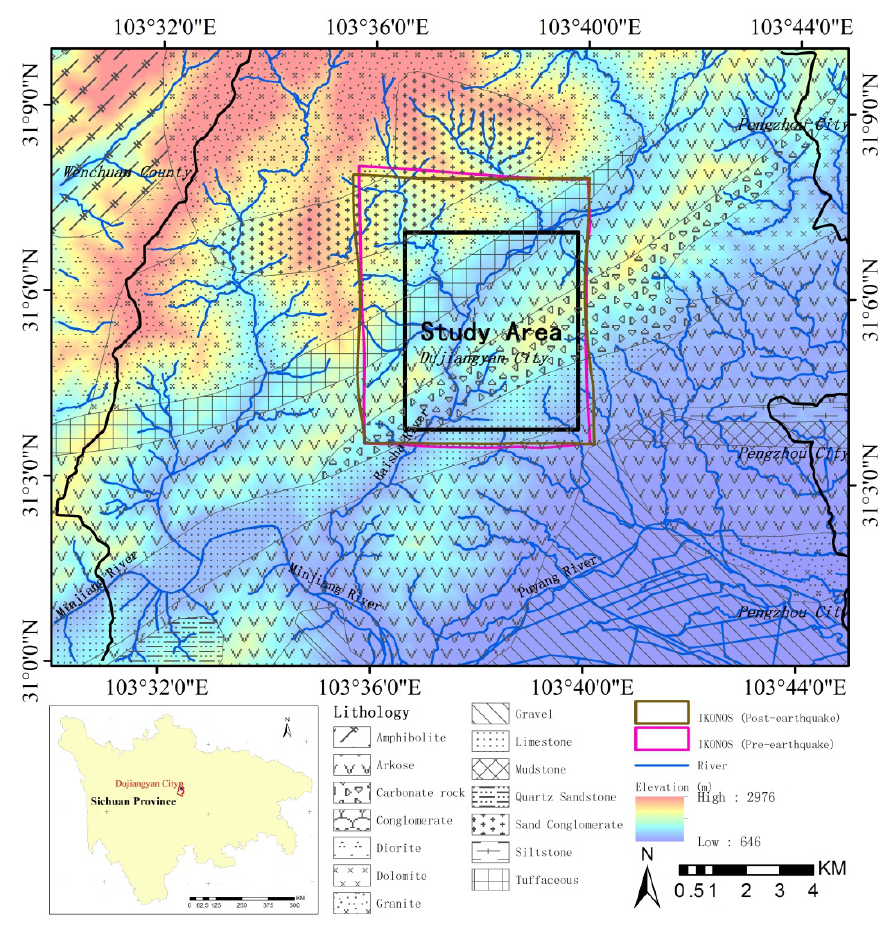
Figure 1. Study area and profile of the data